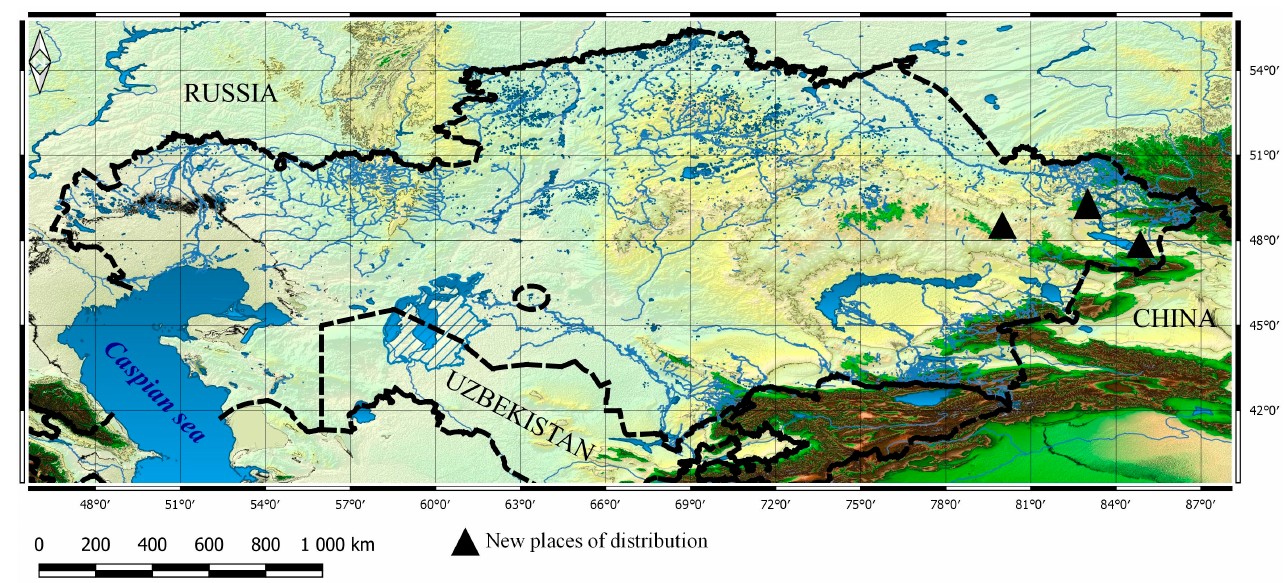
Figure 3. Distribution of Dactylorhiza × kerneri (Soó) Soó in Kazakhstan. East upland: Semipalat, botanical expedition led by M.M. Ilyin, East part, in the valley, the village of Kriushi, meadow along a stream, 21.VI.1928, M.M. Ilyin and A.O. Heinrichson (LE!). Zaysan: Zaysan Depression, Zaisan expedition 1914 of V.V. Sapozhnikov, valley of the Kendyrlik river, near the village Kendyrlik, 4.VI.1914, B.K. Shishkin (LE!). Altai: Kalba ridge, southern part, eastern part of Kandygatay Mountain, the upper reaches of the Kikuntai-Kara-Su river, at the top, gorge, 17.V.1914, N.V. Shipchinsky